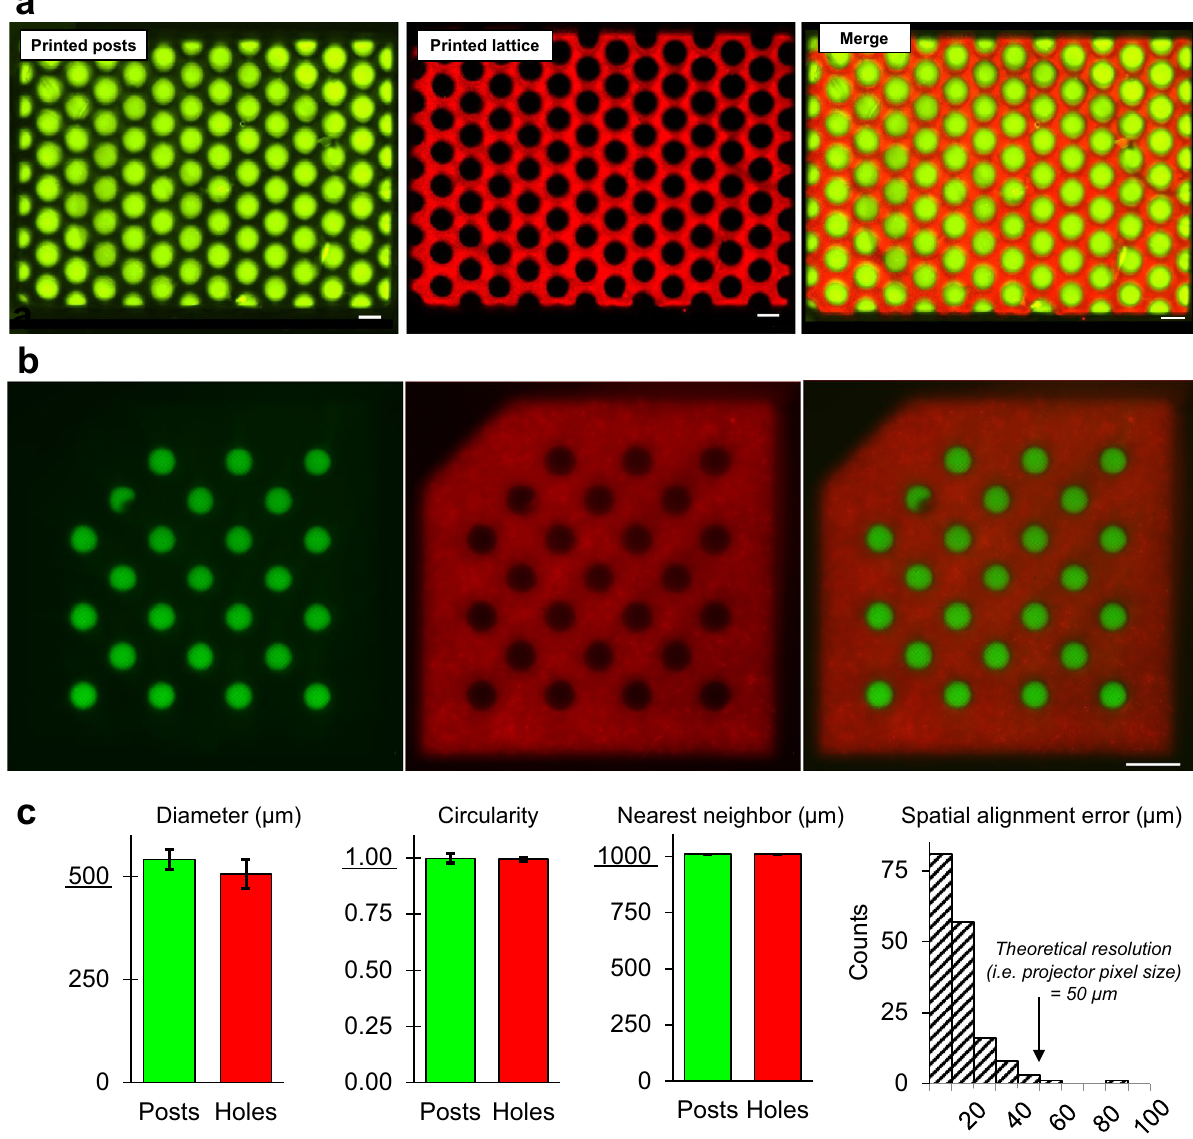
Figure 4. Morphometric quantification of multi-material gels highlights reproducible architectural fidelity. ( a ) Multi-material checkerboard architecture with fluorescent dextrans encapsulated; posts were tightly nested within holes of an open lattice, yielding a covalently bonded monolithic structure free of seams, voids, or other unwanted interfacial defects. ( b ) A similar checkerboard (20% PEGDA, 6 kDa) used as a test case for ( c ) morphometric image analysis. With respect to dimensions from the original CAD file, it was observed that printed feature diameters (500 μm), circularities (1.00), and nearest neighbor distances (1000 μm) were preserved. Importantly, spatial alignment errors for > 98% of nested post/hole pairs were smaller than our projector’s theoretical resolution (i.e. pixel size). This suggests performance was limited by optical hardware, rather than hydrogel formulation or photochemical print parameters. For all graphs n = 3 batches of print solution. Scale bars = 1000